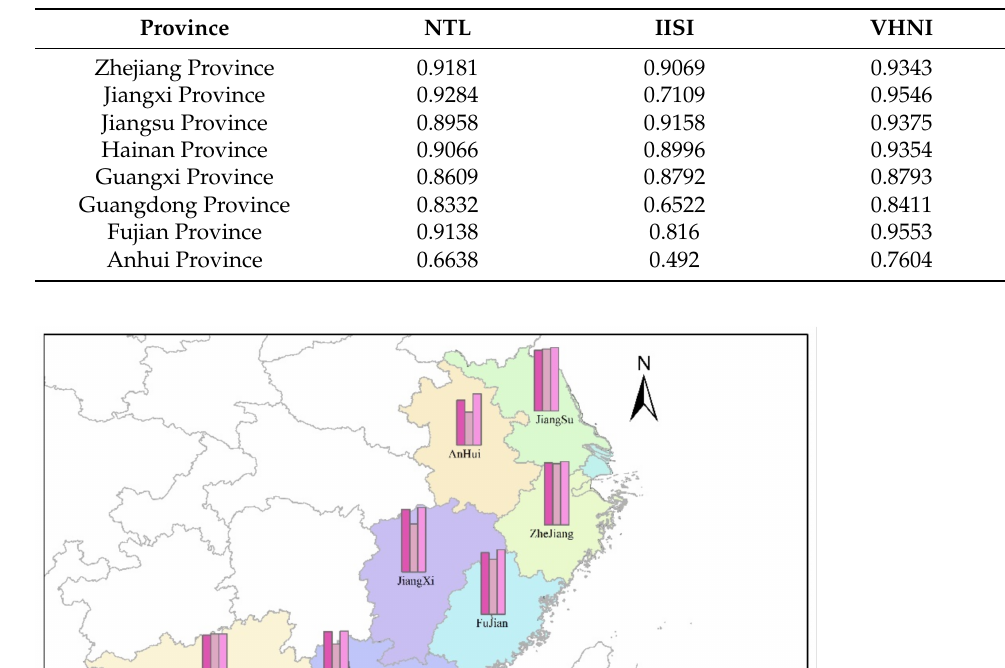
Table 5. Linear regression R 2 of TNL and GDP in each province.